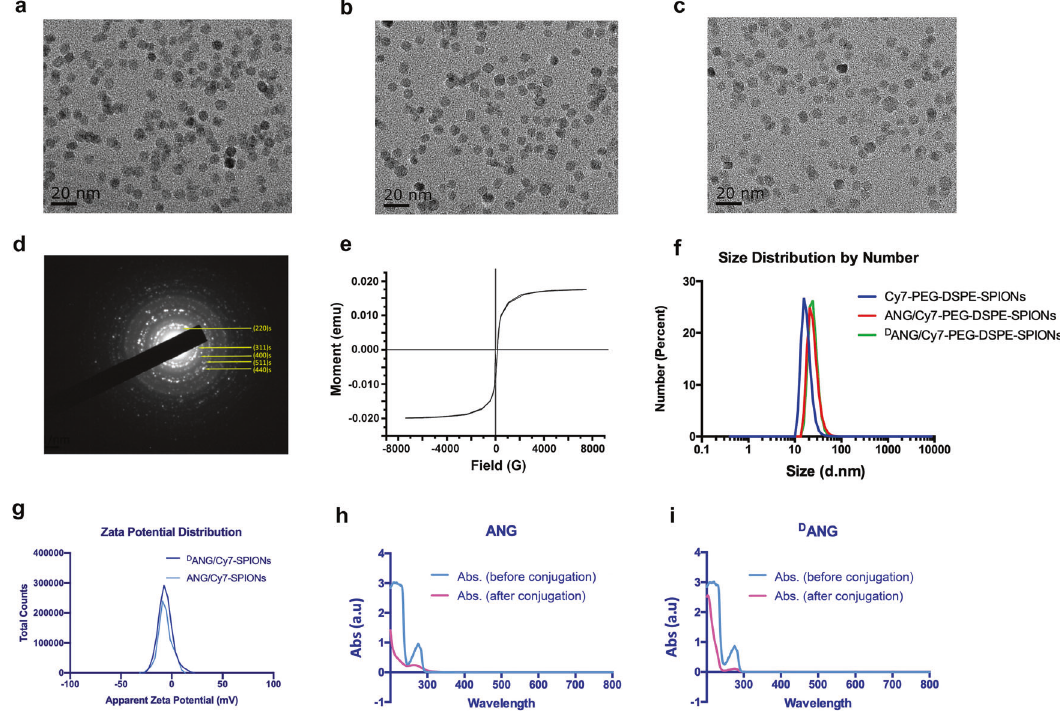
Fig. 2 a Particle size of Cy7-SPIONs, b ANG/Cy7-SPIONs and c D ANG/Cy7-SPIONs; d Selected area electron diffraction pattern of PEG-DSPE- SPIONs; e Magnetic hysteresis curve of NH 2 -PEG-DSPE-SPIONs; f Size distribution of Cy7-SPIONs, ANG/Cy7-SPIONs, and D ANG/Cy7-SPIONs; g Zeta potential distribution of ANG/Cy7-SPIONs and D ANG/Cy7-SPIONs; h UV – vis spectra of ANG and i D ANG before and after